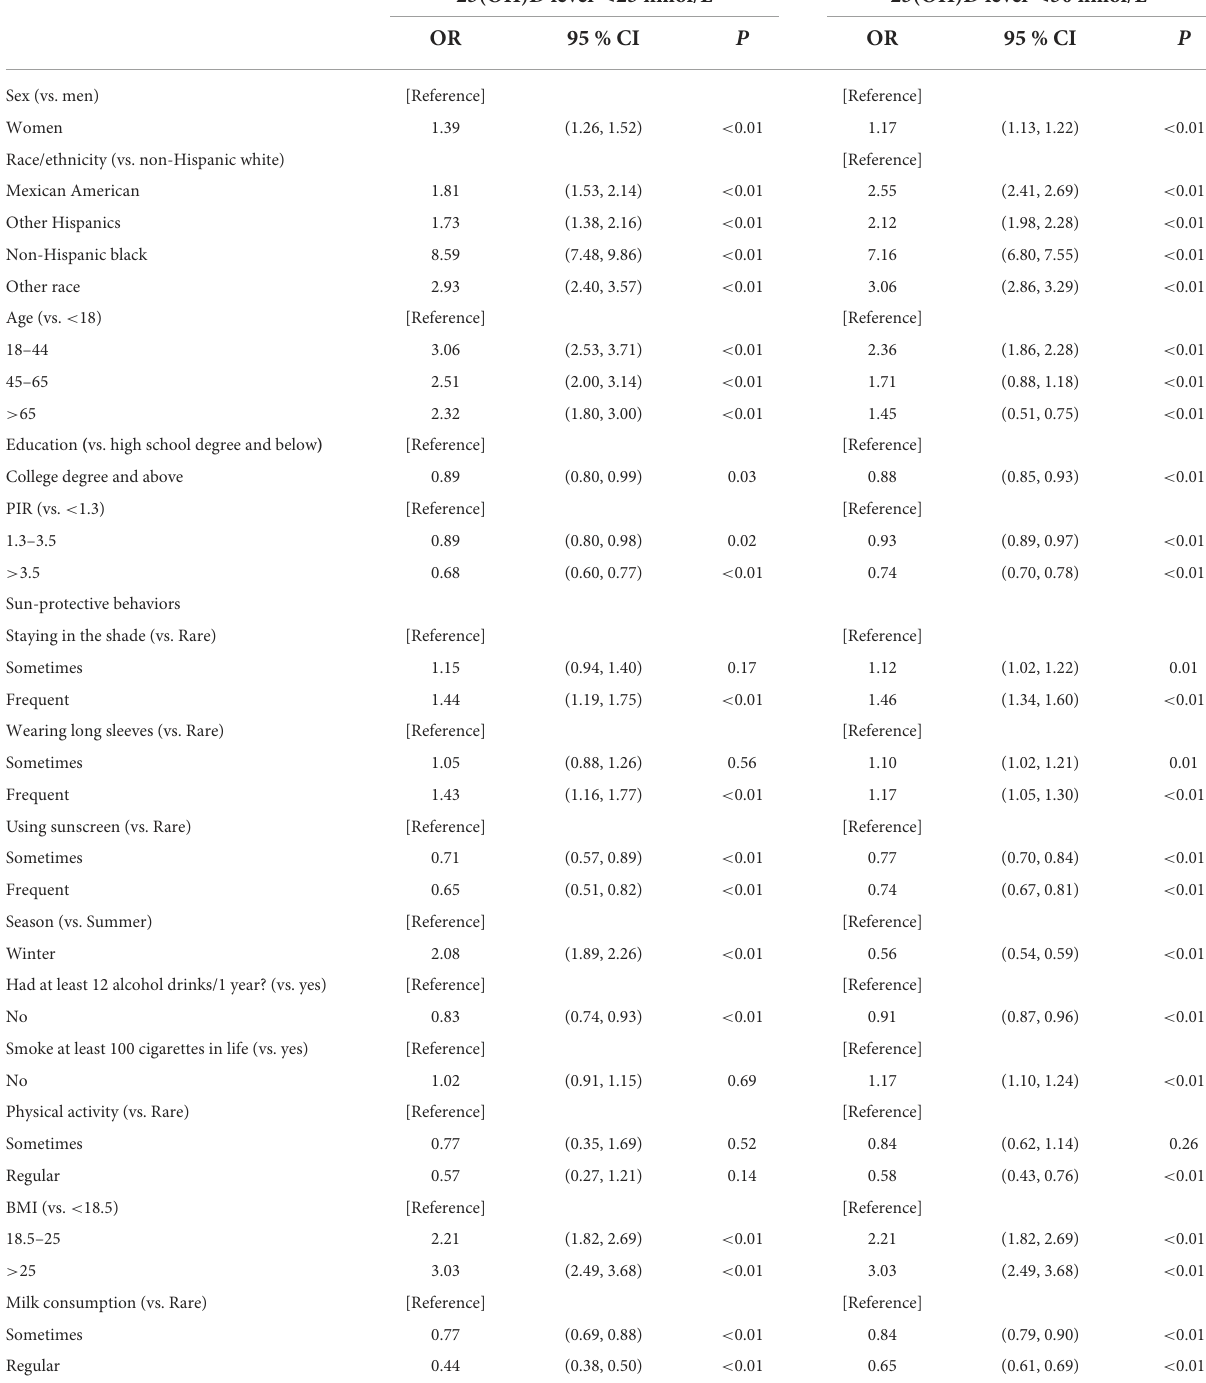
TABLE 4 The results of the predictors of vitamin D deficiency by weighted linear regression